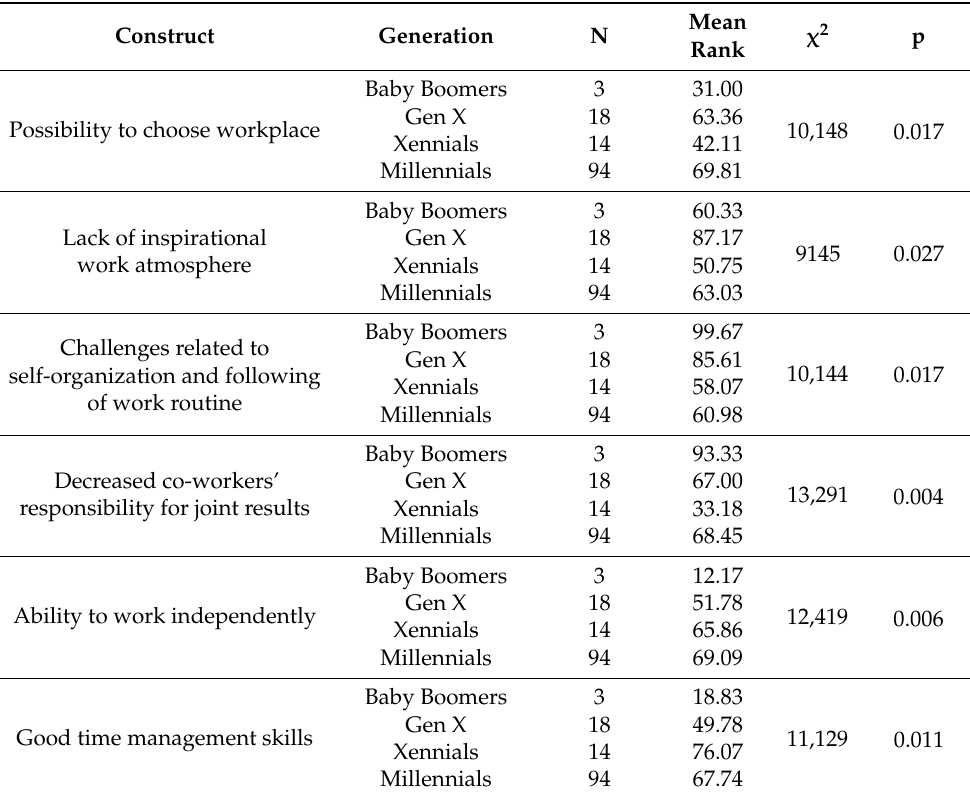
Table 2. The evaluation of teleworking among generations which were telecommuting only during the quarantine.